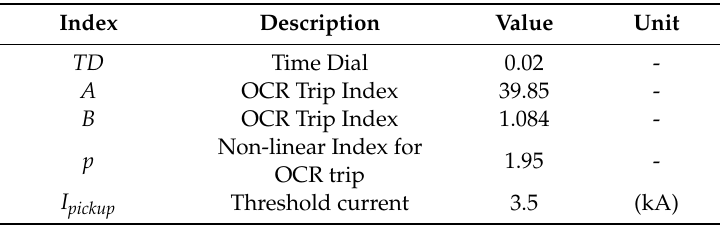
Table 2. Parameters for Designing over Current